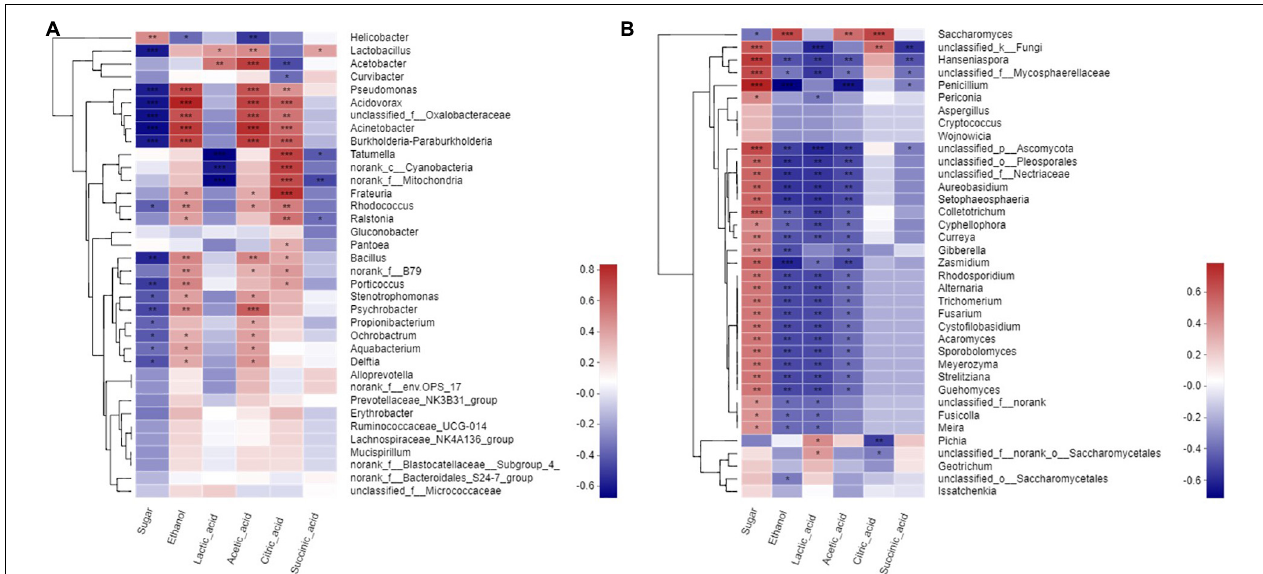
FIGURE 4 | Spearman corelation heatmap of metabolites to microbial. (A) a prokaryotic community, (B) eukaryotic community at genus